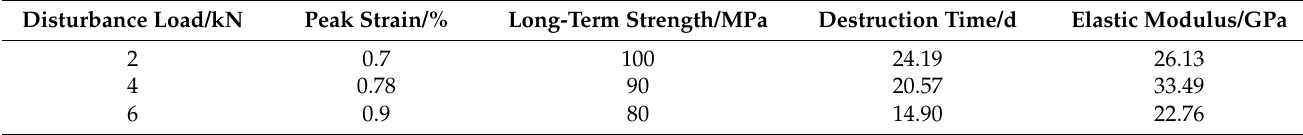
Table 3. Summary of the mechanical properties of the specimens under different disturbance loads.